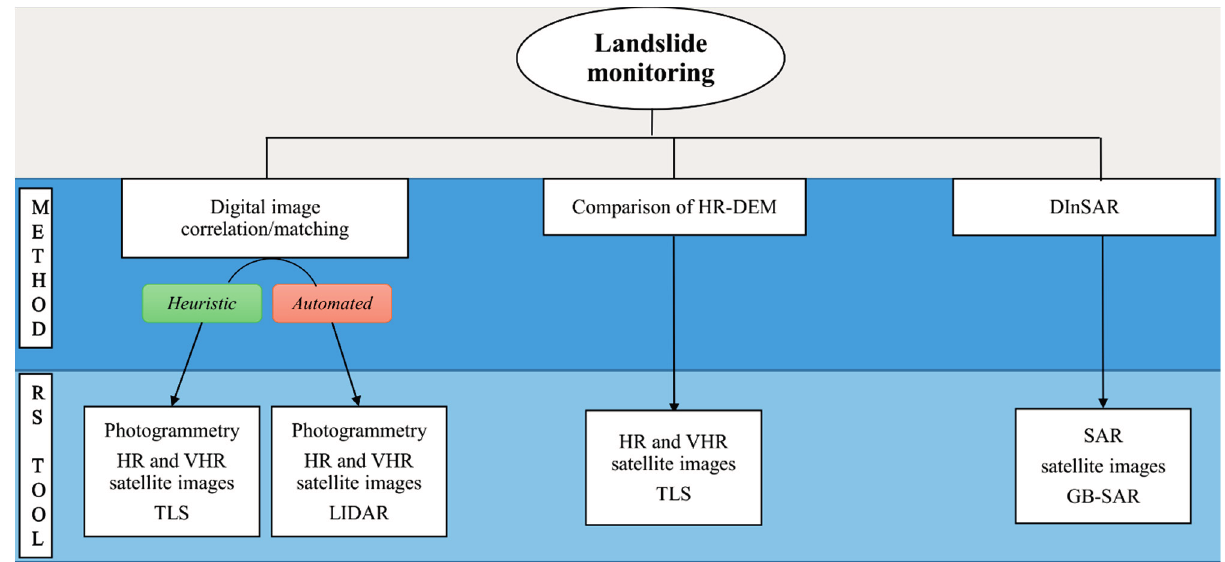
Figure 2. Overview of Remote Sensing techniques for landslide monitoring.